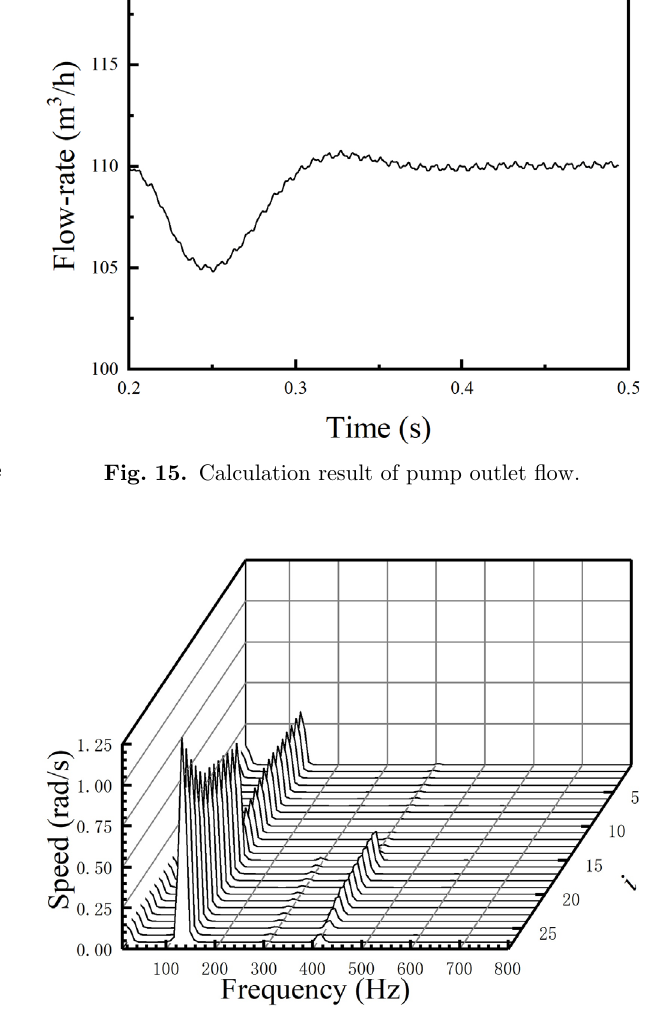
Fig. 16. Rotational speed fl uctuation spectrum at different positions of the